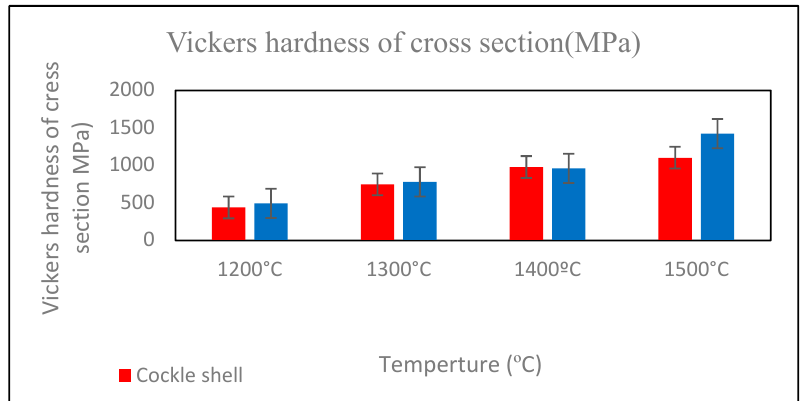
Figure 11. Vickers hardness of cross-section of Ca-SZ(CS); red line and Ca-SZ(CC); blue line when sintered for 2 h at different temperatures of 1200, 1300, 1400 and 1500 ° C.